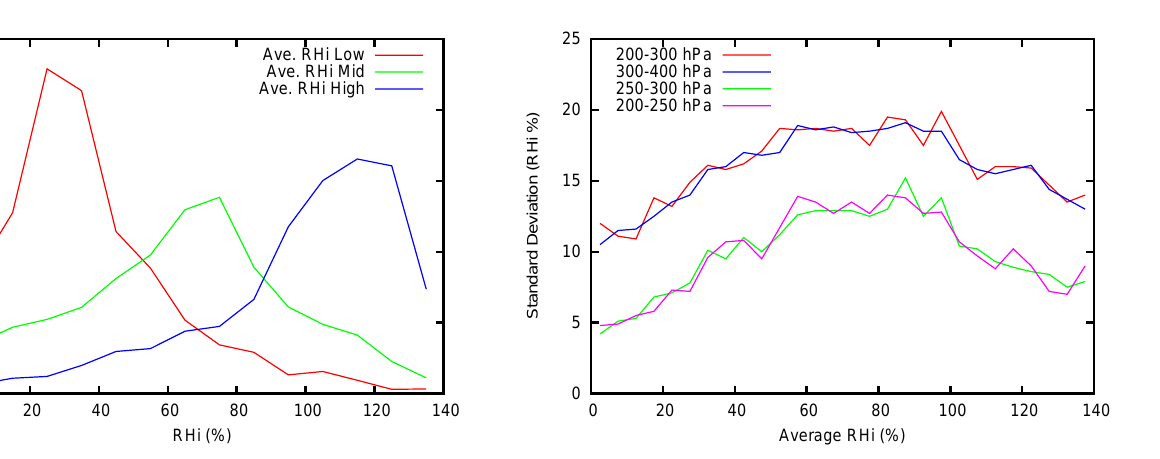
Fig. 14. Standard deviations ( σ u ) versus average RHi (bin-wise) in 50- and 100-hPa pressure layers. The data are derived from the British Isles dataset (January 2002–December 2006).